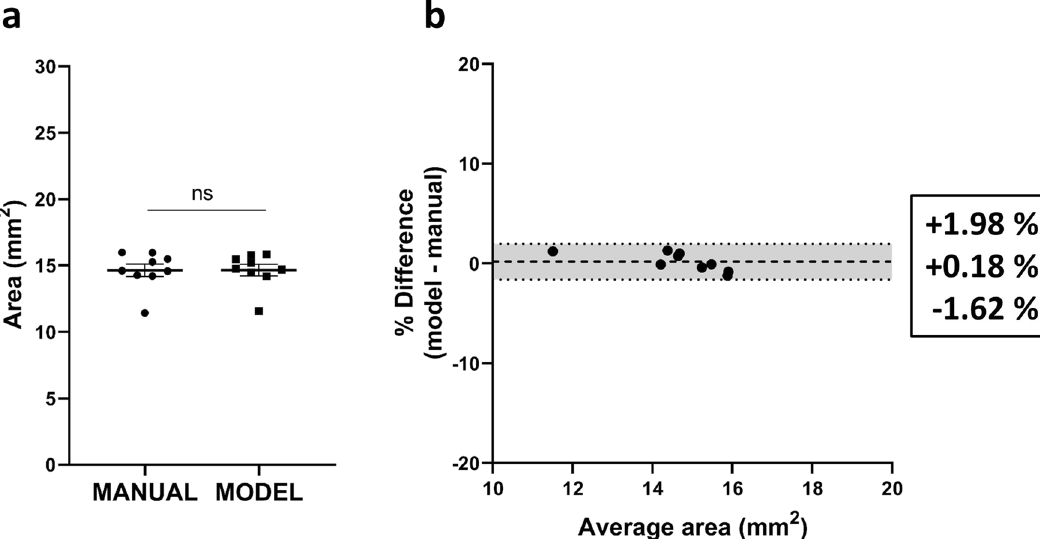
Figure 4. Estimation of retinal area and bias analysis of automated segmentation on retinal flatmounts. ( a ) Comparison of manual and automated segmentation of the retinal area (mean ± SEM) revealing no significant difference between both methods (unpaired two-tailed t test). ( b ) Bland–Altman analysis of the automated versus manual segmentation. Mean bias ± 95% limits of agreement are